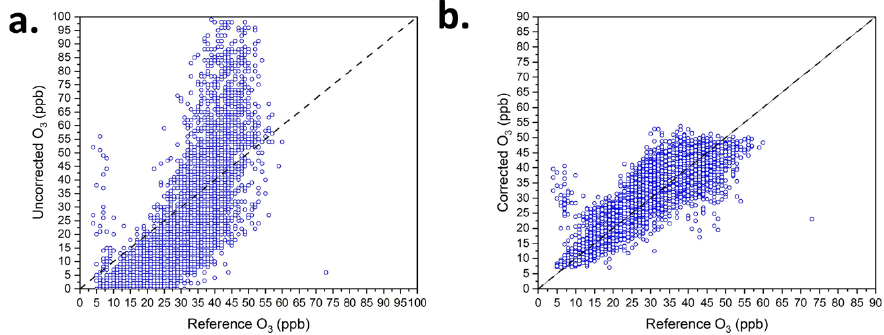
Figure 6. ( a ) Uncorrected O 3 sensor readings versus the observed reference NO 2 concentration, ( b ) RF-corrected O 3 sensor readings versus the observed reference O 3 concentration. Both diagrams refer to the test year (2022).